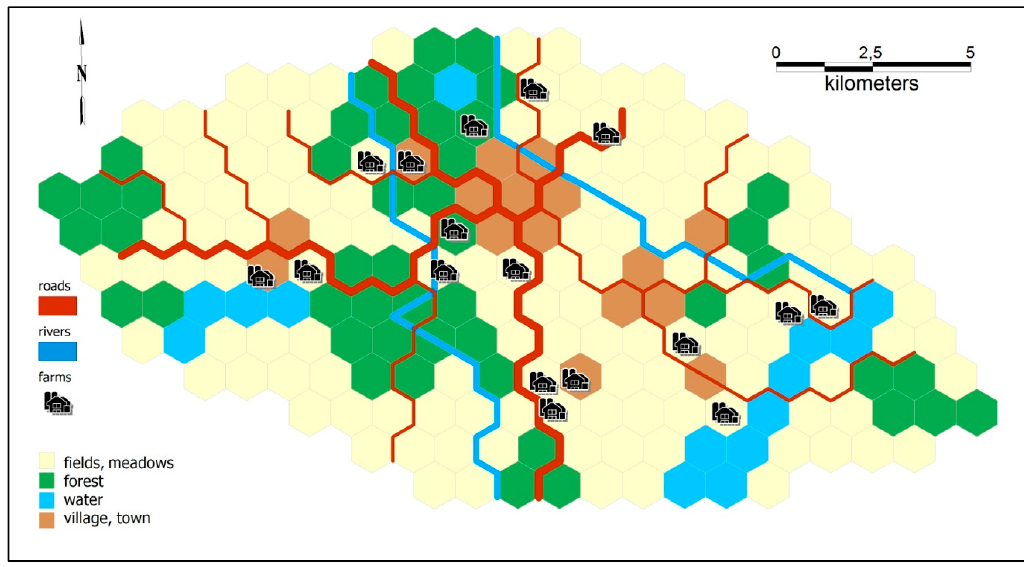
Figure 1. A generalised map of the Ż uromin commune with a hexagonal division developed in the Arc geographic information system (ArcGIS) environment (the authors’ own work).